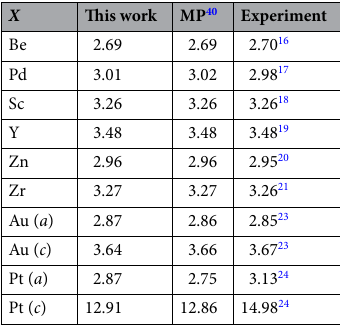
Table 3. The lattice parameters of Cu X in the B2 structure, CuAu in the L1 0 structure, and CuPt in the L1 1 structure. For the L1 1 structure, the parameters of the conventional unit cell (including six atoms) are